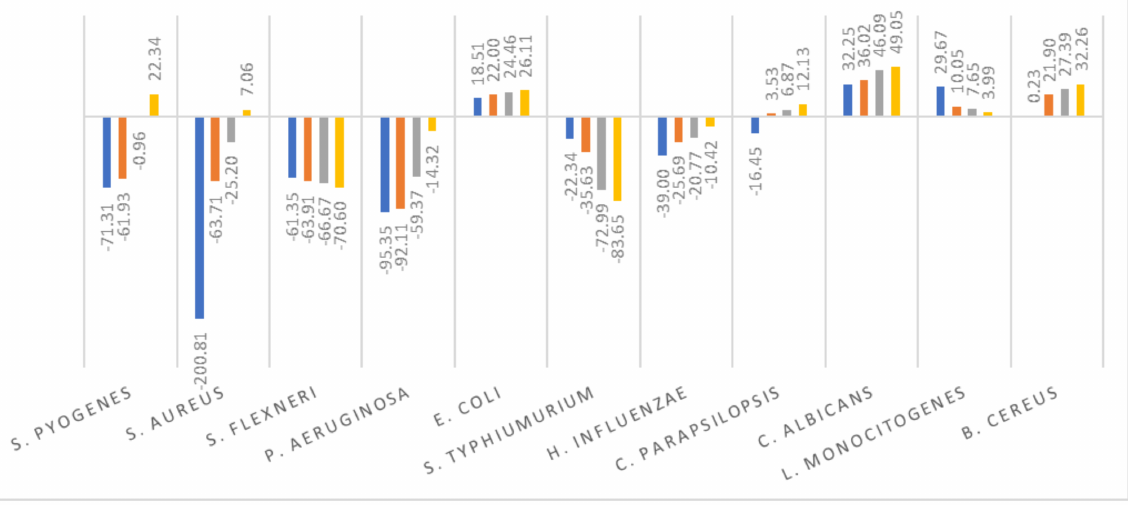
Figure 14. Plain polyfloral honey antimicrobial activity (expressed as BIR%/MIR%) on